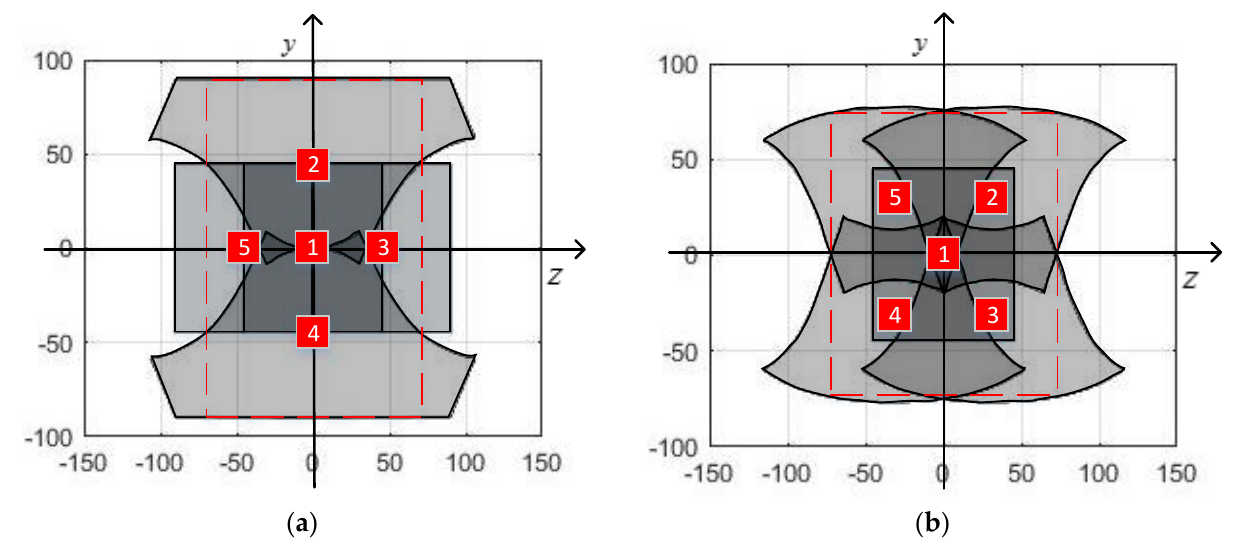
Figure 6. Rectangular FOV sensors array overlay diagrams. ( a ) +-shaped layout. ( b ) X-shaped lay- out.